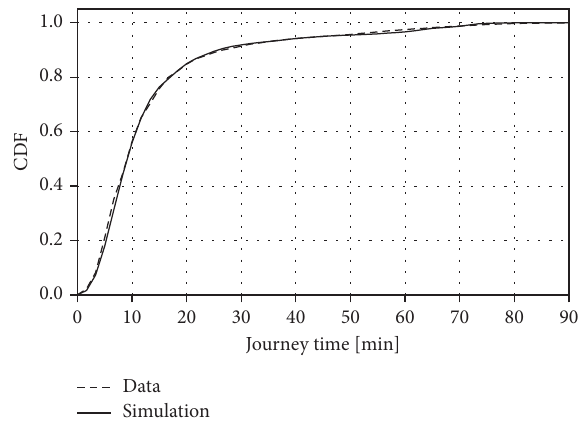
Figure 4: Comparison of journey times in simulation and in the original data set for Chicago